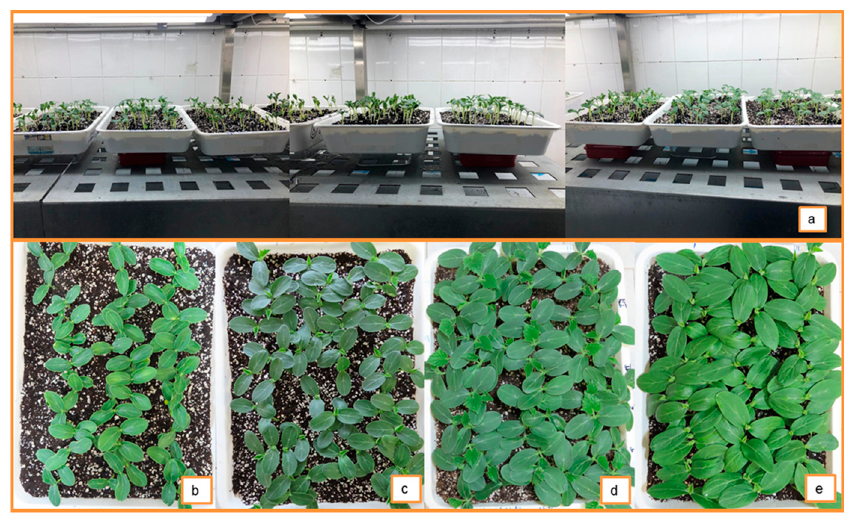
Figure 1. ( a ): cucumber seedlings in the growing cabinet, ( b ): seedling growth at 15 °C +salt, ( c ): seedling growth at salt, ( d ): seedling growth at 15 °C, ( e ): seedling growth at control.